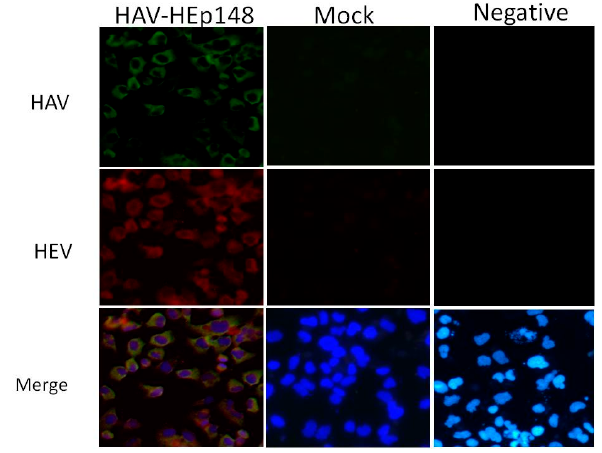
Figure 3. Immunofluorescence (IF) analysis of HAV-HEp148-infected Huh-7 cells. Monolayers of Huh-7 cells were either infected with HAV-HEp148 or mock-infected, fixed with acetone at 7 days post infection (p.i.), and stained with antiserum directed against HAV (green), and antibodies against HEV capsid (ORF2) protein (red). Negative serum was used as a negative control for antibodies in transfected cells. Merged images also show nuclear labeling with DAPI. Micrographs were taken with a Nikon microscope at a 400× magnification.